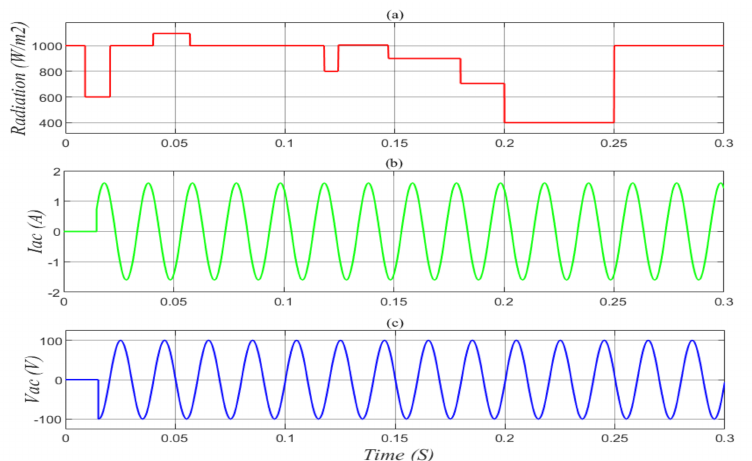
Figure 13. Current load, AC load output under load constant, and radiation changes. ( a ) The load current, ( b , c ) AC load time.